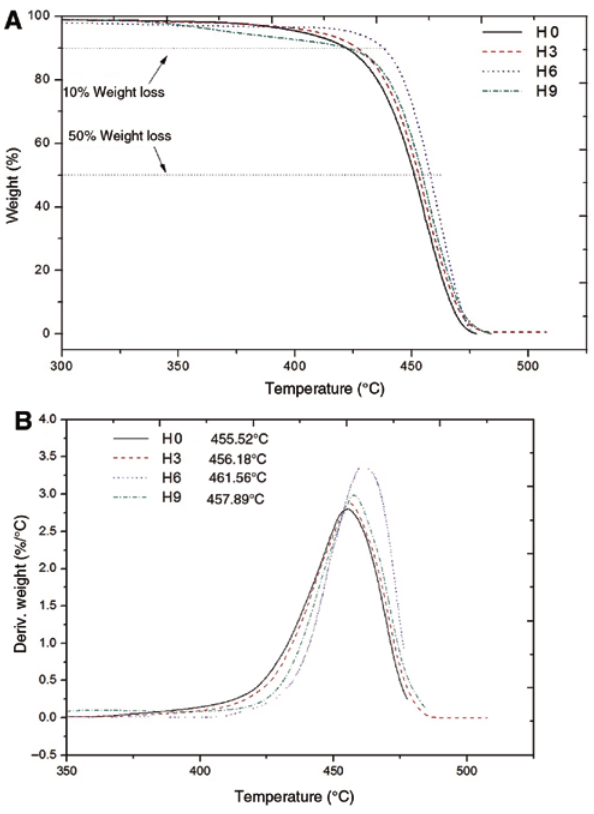
Figure 3: (A) Thermogravimetric analysis (TGA) and (B) derivative TGA of the PP/LDH composites containing different LDH